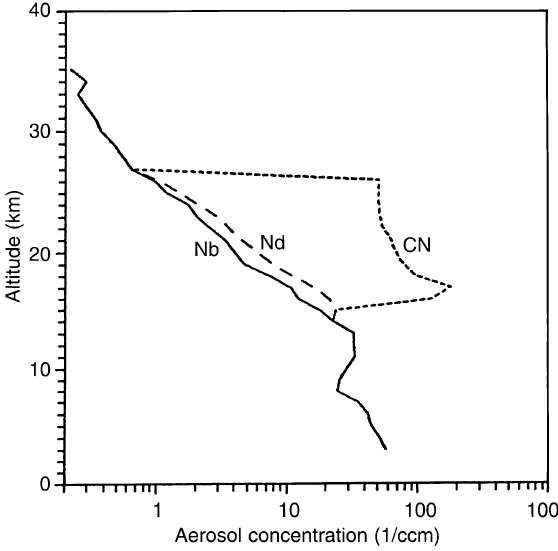
Fig. 5. Aerosol concentration profiles calculated from experimental lidar measurements on 15 February 1984 ( Nb ) is quiet day level, and on 18 February 1984 ( Nd ) is disturbed level. Curve CN (condensa- tion nuclei) gives CN concentration profile calculated for GLE event using ion nucleation